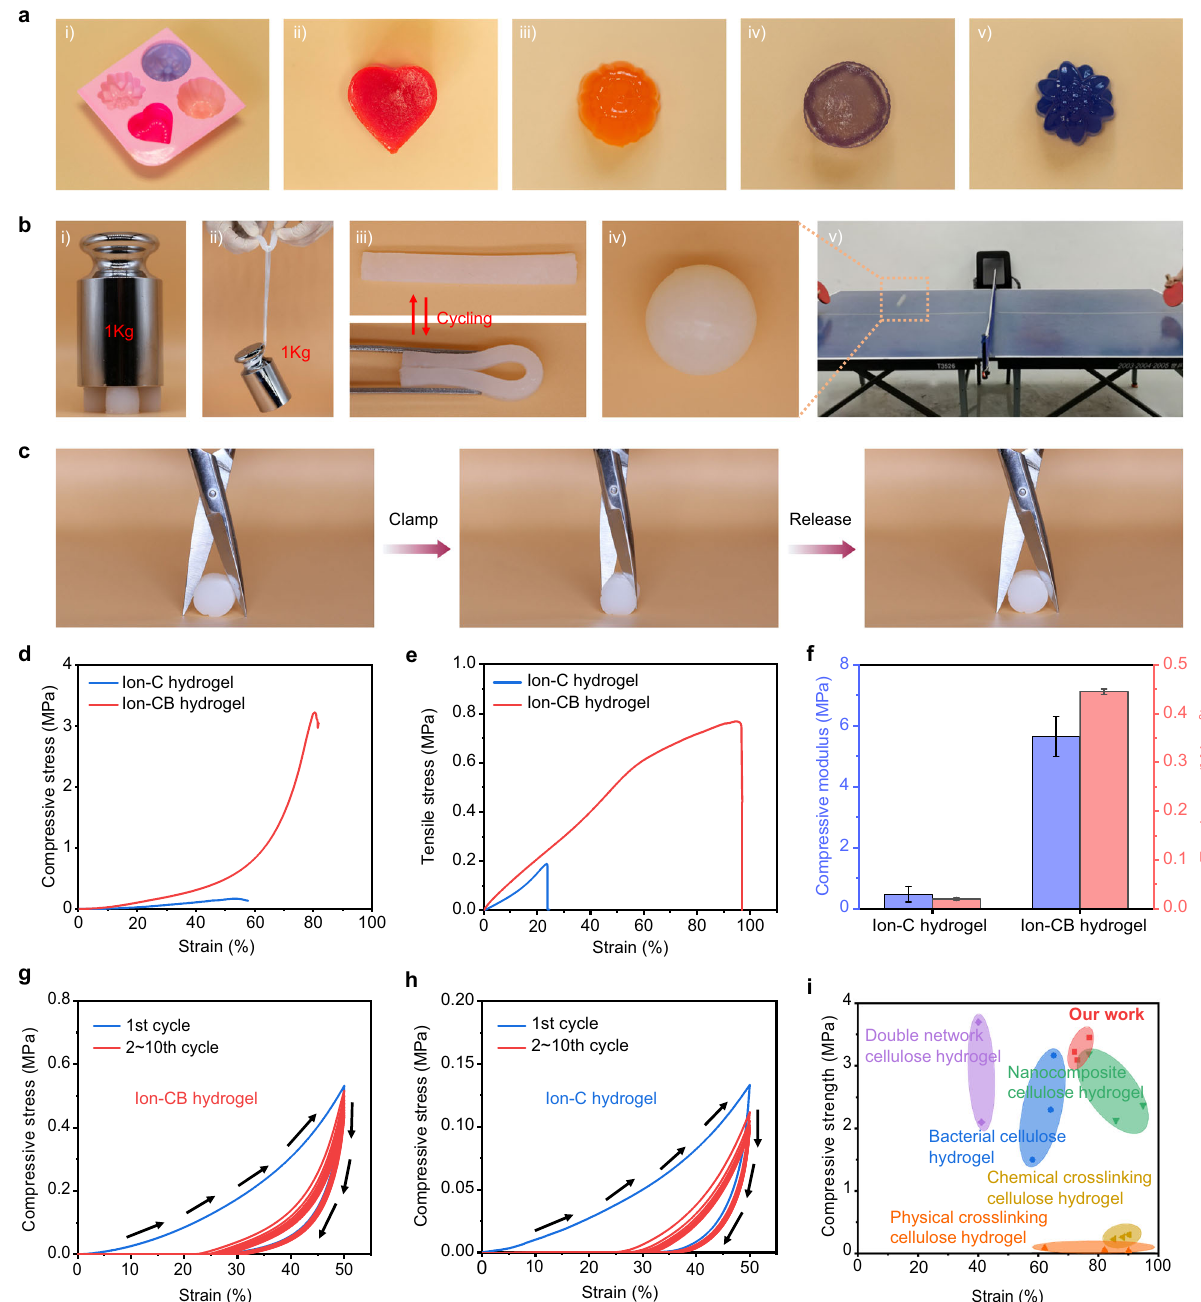
Fig. 4 Mechanical properties of the cellulosic hydrogels. a Photographs of Ion-CB hydrogels formed in the different mold. b Photographs of Ion-CB hydrogels under various external forces. c Photographs of the Ion-CB hydrogel cut by a scissor. d Compressive stress-strain curves of the hydrogels. e Tensile stress-strain curves of the hydrogels. f Compressive modulus and toughness of the hydrogels. Data are presented as mean values ± SD, n = 3 independent samples. g , h Cyclic compressive stress-strain curves of Ion-CB hydrogel ( g ) and Ion-C hydrogel ( h ) with a maximum strain of 50%. i The mechanical properties of Ion-CB hydrogels and other reported cellulose-based hydrogels, including double network cellulose hydrogel 42 , nanocomposite cellulose hydrogel 43 , chemically cross-linking cellulose hydrogel 44 , physical cross-linking cellulose hydrogel 45 , and bacterial cellulose hydrogel 46